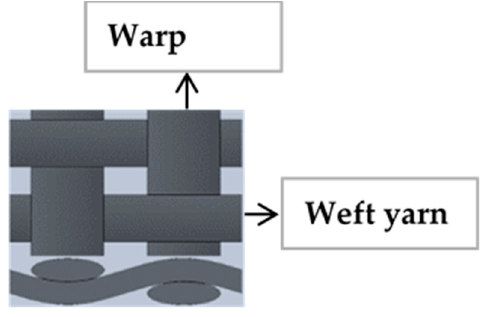
Figure 1. Plain weave pattern.